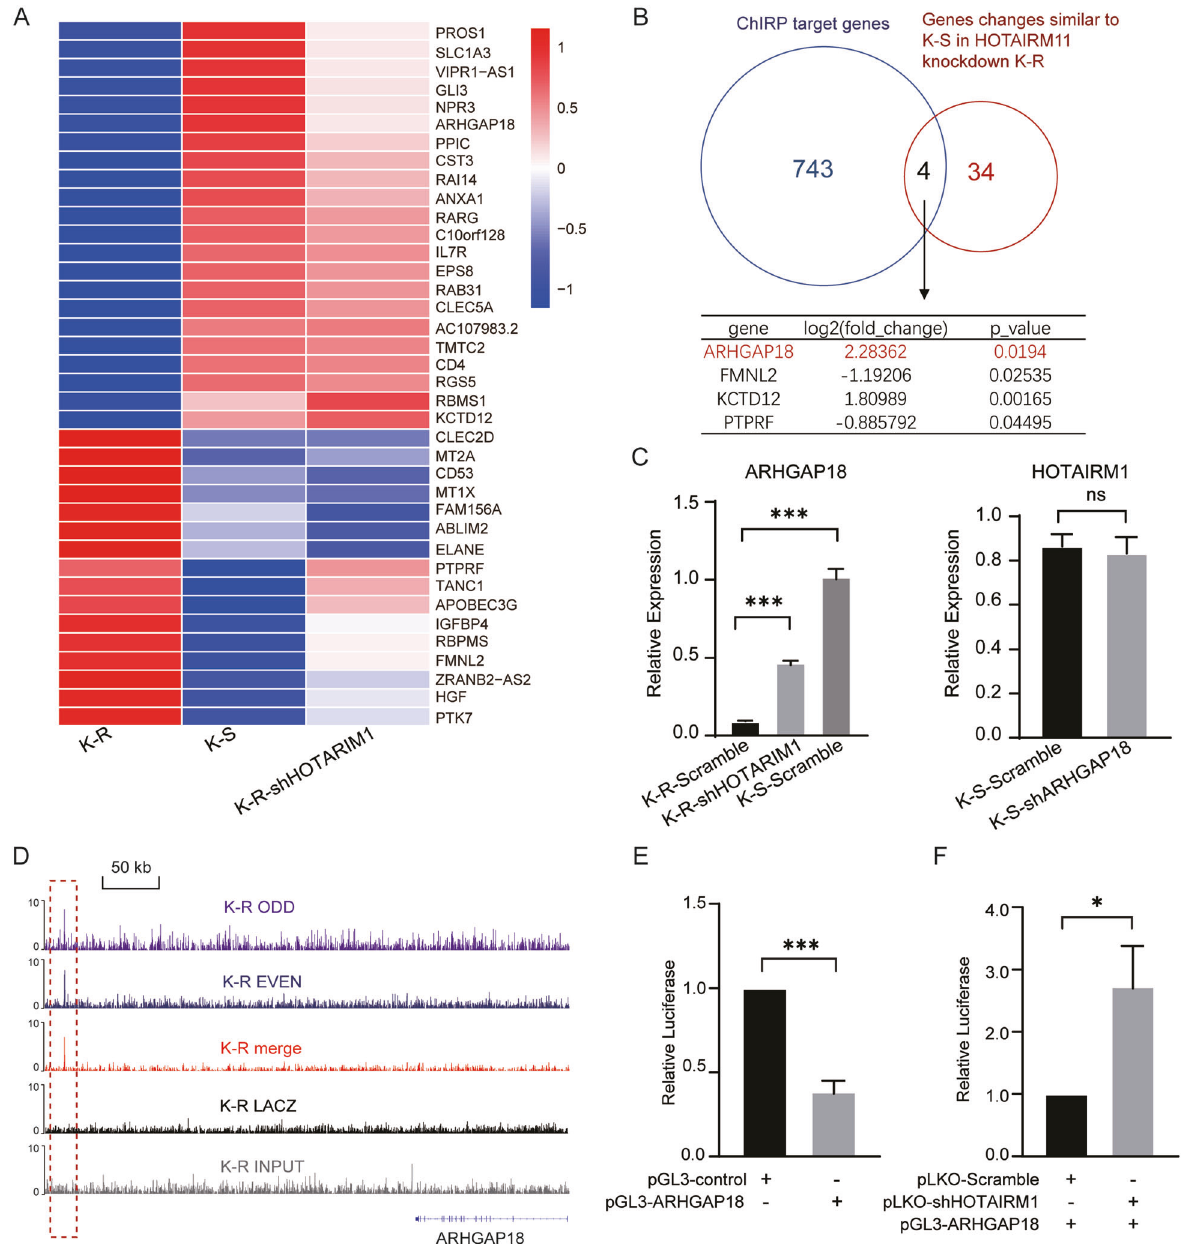
Fig. 5 ARHGAP18 was suppressed by HOTAIRM1 binding. A Heatmap of the genes expression level, which may be regulated by HOTAIRM1 and contribute to GC resistance. B ARHGAP18 were selected by overlapping the ChIRP target genes and the genes, which became similar to K- S after HOTAIM1 knockdown in K-R. C The expression levels of ARHGAP18 were measured in K-S-scramble, K-R-scramble, and K-R with HOTAIRM1 knockdown using qRT-PCR (left). HOTAIRM1 was not affected by the knockdown of ARHGAP18 in K-S (right). D Tracks of the HOTAIRM1 binding peaks near the ARHGAP18 gene locus in ChIRP-seq data. The dark blue represents the even probe group, the purple represents the odd probe group, the red represents the peak of the merged odd and even probe data, the gray represents the LacZ probe group, and the black represents the input, the red dashed box represents the binding peak. E K-R cells were transfected with the HOTAIRM1 binding sequence of ARHGAP18 in luciferase reporter assay. Luciferase activity was compared with that of the empty construct with pGL3 promoter. F pGL3-ARHGAP18 were co-transfected into K-R cells with either nontargeting control vectors or HOTAIRM1-targeting shRNA vectors. Data information: Data were represented as mean ± SD, n = 3 ( C, E – F ). Difference between groups was assessed using Student ’ s t -test: * p < 0.05, ** p < 0.01, *** p < 0.001, ns means no statistical signi fi